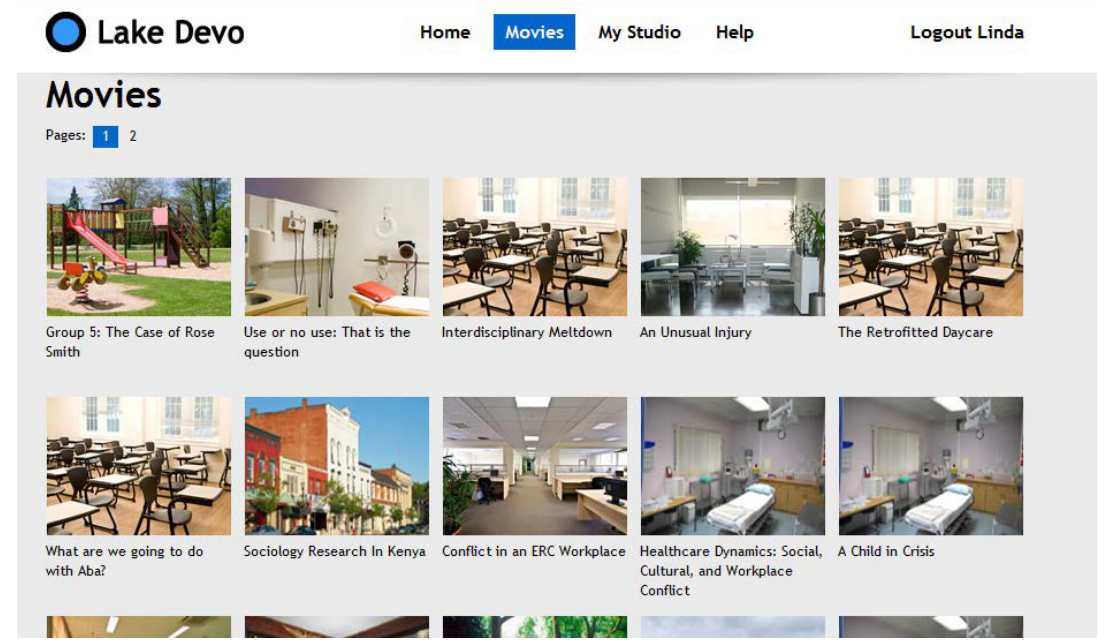
Figure 1. Screenshot of the Lake Devo Movies